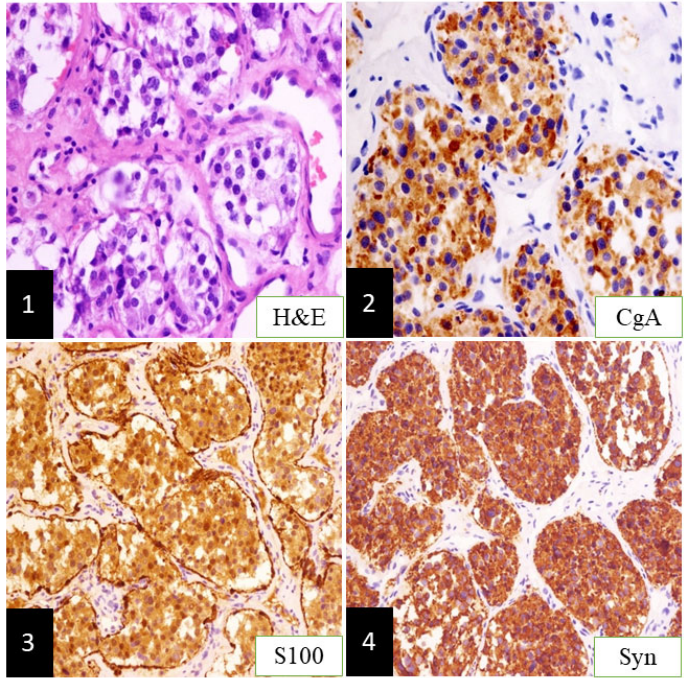
Brain Sci. 2022 , 12 , x FOR PEER REVIEW Figure 2. Pathological findings of intracranial lesion. ( 1 ): showing multiple chromaffin cytes surrounded by the vascular web and sustentacular cells; ( 2 ), ( 3 ), and ( 4 ): displaying immunohistochemistry results where CgA, S100, and Syn expression were positive (paraganglioma, magnification × 100).